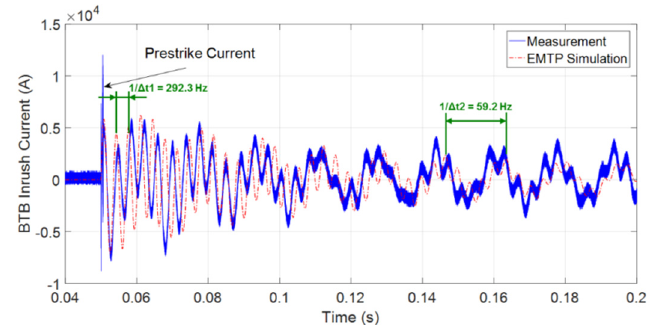
Figure 12. Inrush currents for 5th harmonic filter (HF5) energization.